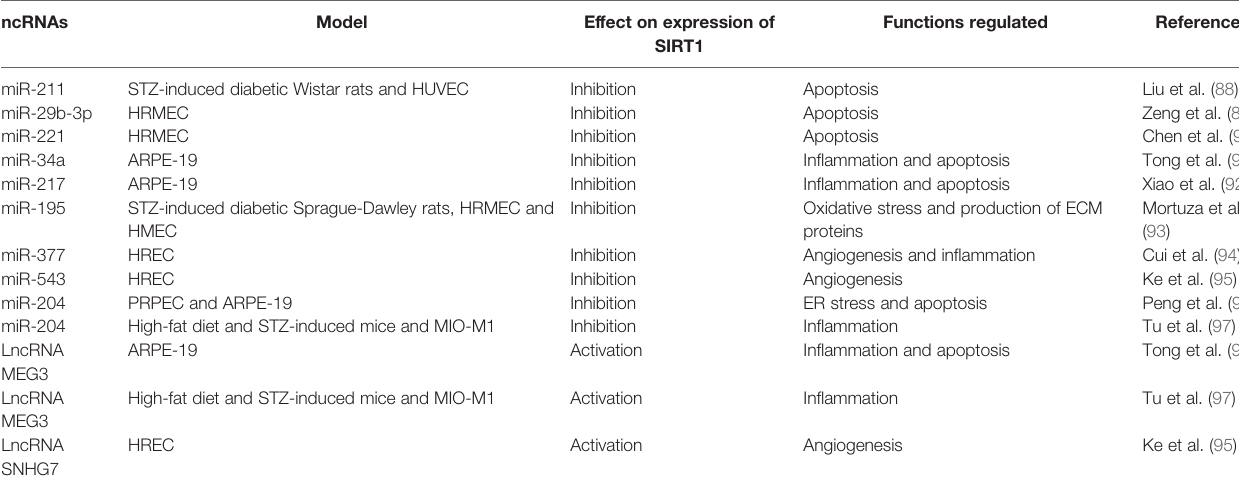
TABLE 1 | The role of ncRNA-mediated SIRT1 changes in diabetic retinopathy.